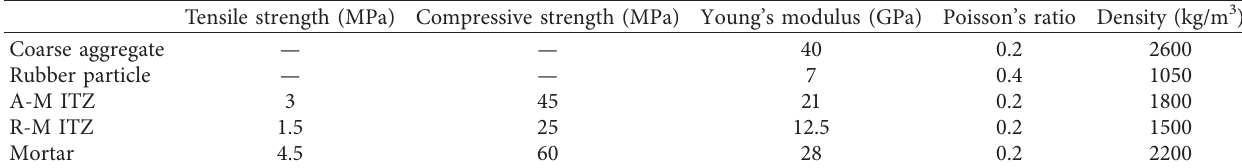
Figure 21: Effect of rubber volume fraction on peak stress for rubber replacing sand models. Table 4: Material parameters for the rubberized concrete mesoscale model with rubber replacing